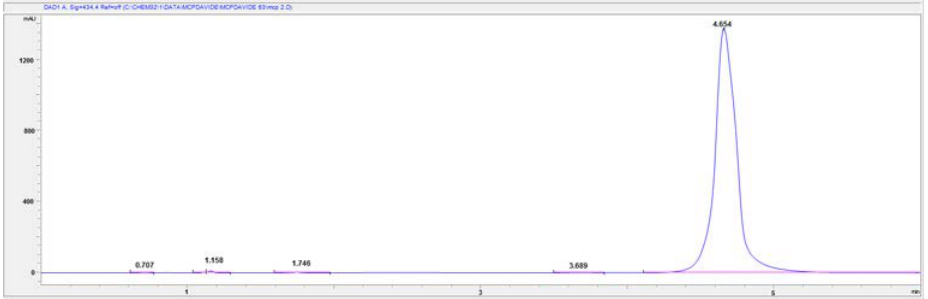
Figure 7. HPLC-DAD chromatogram of 2.5 mM mCP standard solution detected at 434 nm wave- length. Eluent composition: 15% CH 3 CN and 85% H 2 O adjusted at pH 8.0.